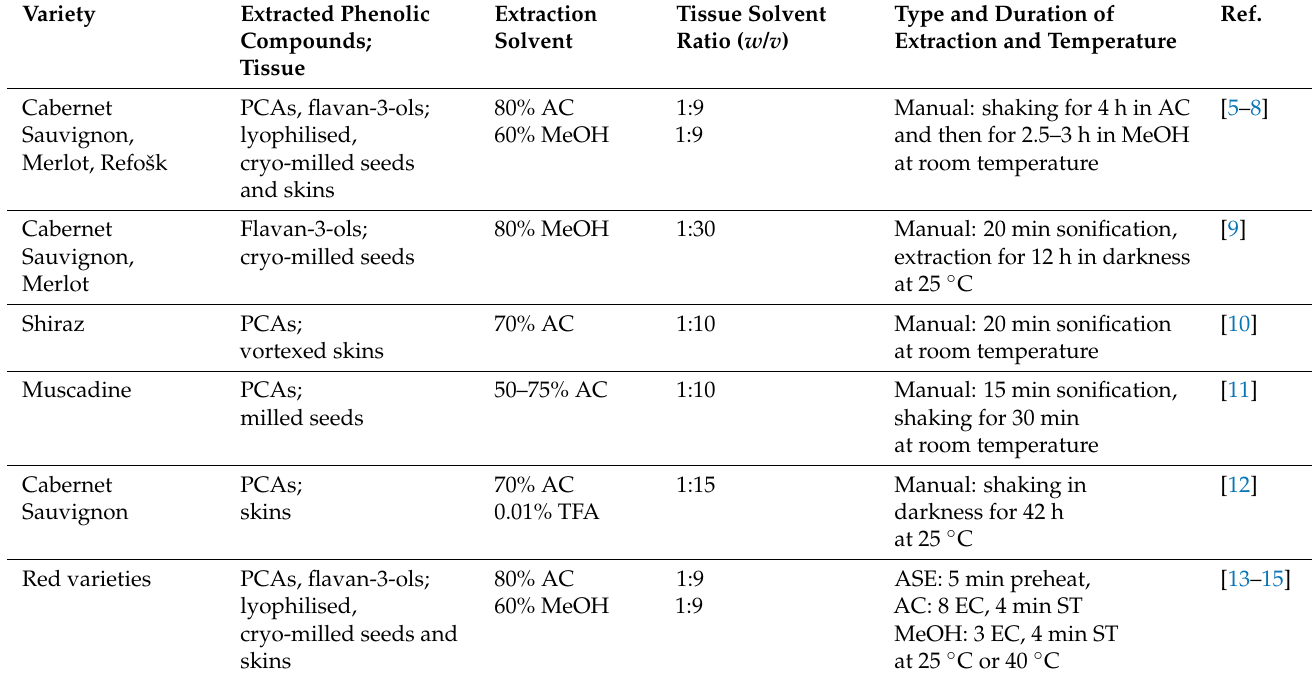
Table 1. Methods for the phenol extraction from grape seeds and skins with organic-aqueous